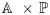
Graded plasticity reduces the ability to overcome the APT, indicating that metaplasticity is crucial for adaptive learning.(a) Schematic of the simple-family graded plastic models. This model has an equal number of states and transitions as the metaplastic model, but with different values of synaptic efficacy assigned to different states. (b) Plotted is the average A  × ℙ in the graded plastic models with four states as a function of the single transition rate and the efficacy of the least weak state (efficacy = 1 is equivalent to the N = 4 meta-plastic model). (c) Plotted is the average A  × ℙ in the graded plastic models with six states as a function of the efficacy of the weaker states when the single transition rate was set to 0.2 (efficacy1 = efficacy2 = 1 is equivalent to a superior meta-plastic model with six meta-states). (d) The same as in (c) but for the transition rate equal to 0.7. Overall, A  × ℙ monotonically increased as the graded plastic model became similar to the metaplastic model.